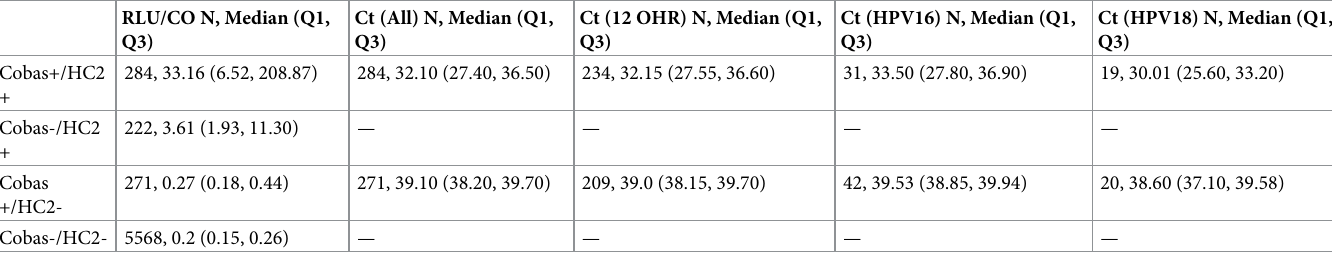
Table 2. RLU/CO and Ct values for concordant and discordant cases. RLU/CO N, Median (Q1,